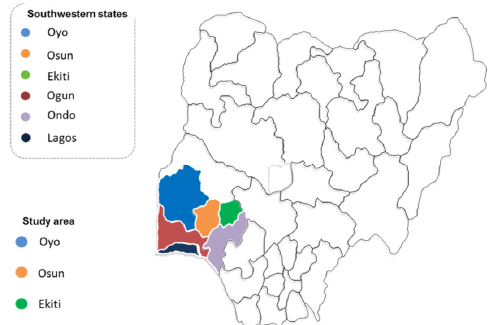
Fig. 1. Map showing study